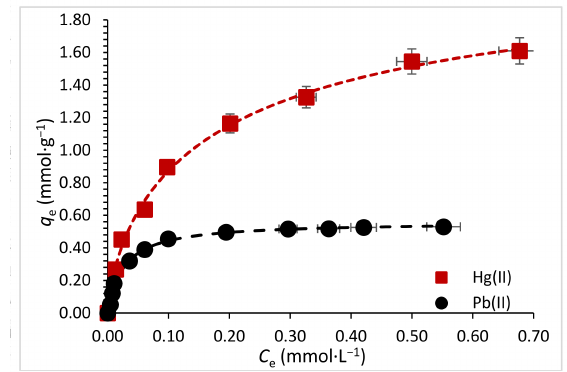
Figure 5. Single component sorption isotherms. ( T : 20 ◦ C; sorbent dosage: 1 g · L − 1 ; agitation speed: 180 rpm; contact time: 48 h).